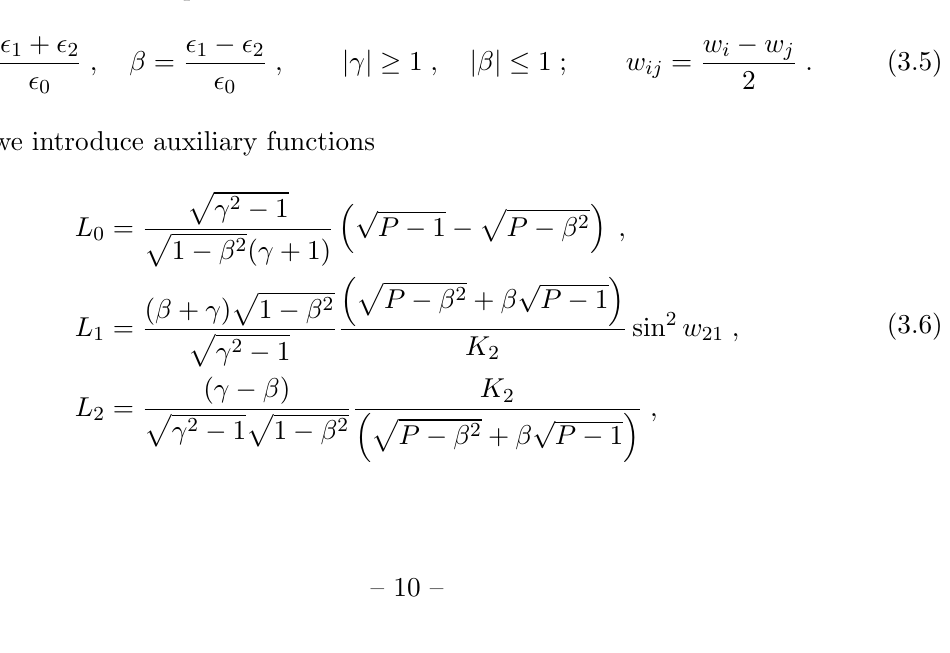
w 2 Figure 4 . (a) general N = 3 tree with two boundary endpoints and arbitrary point on the disk (b) the third point on the center of the disk (c) the third point on the boundary